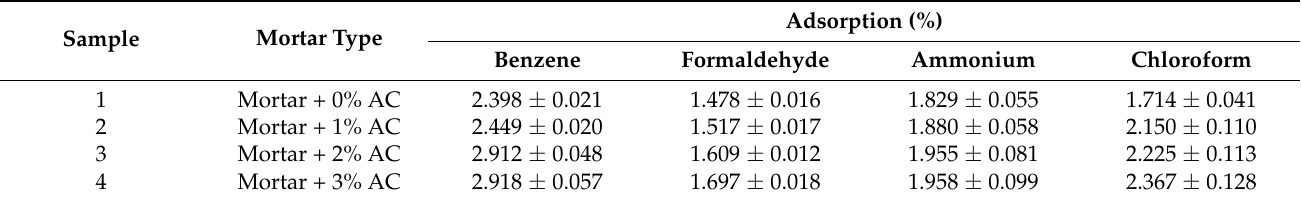
Table 6. The absorption of pollutants from the mortar with the addition of OPS-activated charcoal.